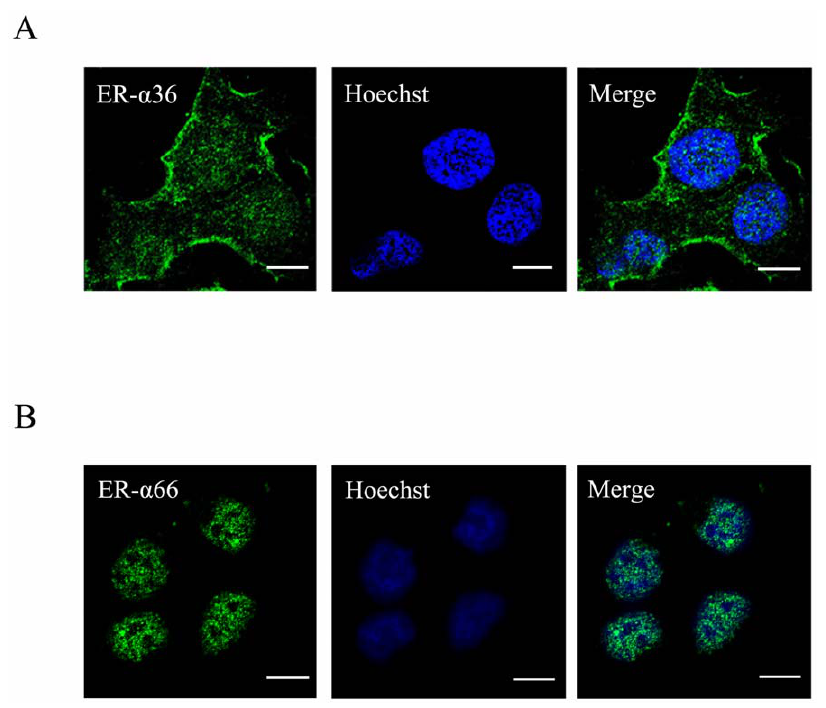
Figure 1. Subcellular localization of ER- a 36 and ER- a 66 in Ishikawa cells. A. Ishikawa cells cultured on coverslips were fixed and immunofluorescently stained with the anti-ER- a 36 specific antibody (green). The cells were also stained with Hoechst 33258 (blue) to show the cell nuclei. B. ER- a 66 expression detected by immunofluorescence in Ishikawa cells. The nucleus was stained by Hoechst 33258. Bar, 10 micrometers.